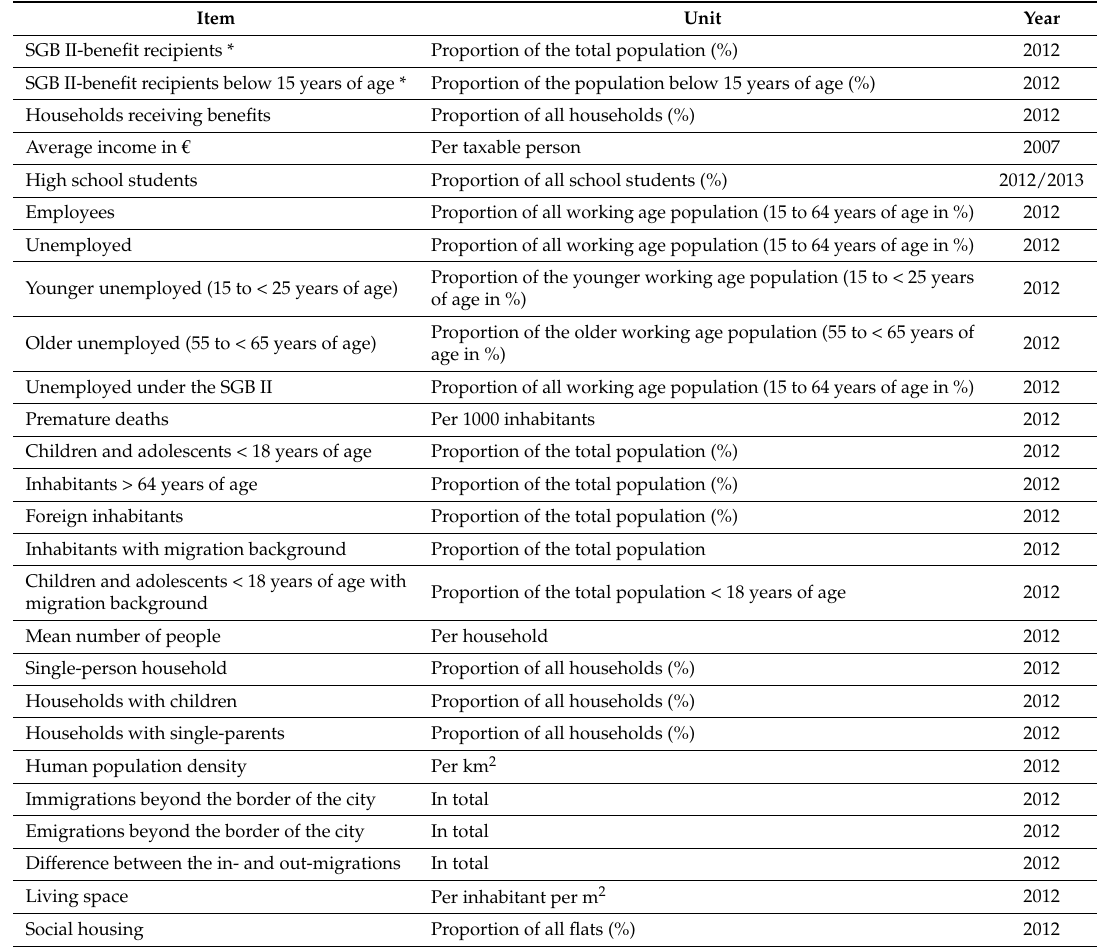
Table 2. Indicators considered for the Principal Component Analysis